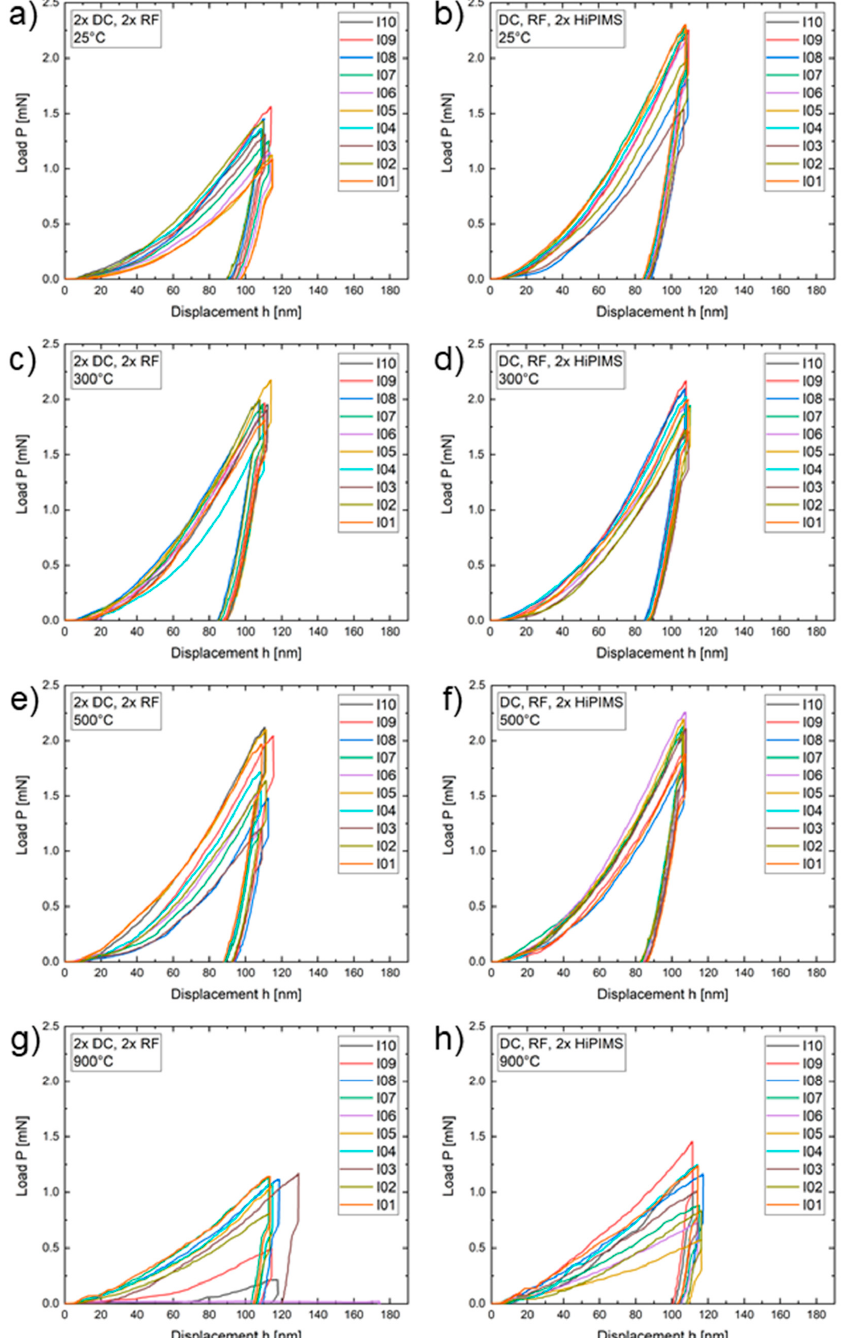
Figure 5. Nanoindentation load–displacement results of 10 indents spaced 15 µm apart with a final indentation depth of 100 nm. ( a – h ) The power supply arrangements and deposition temperature for each CrCoFeNi sample.